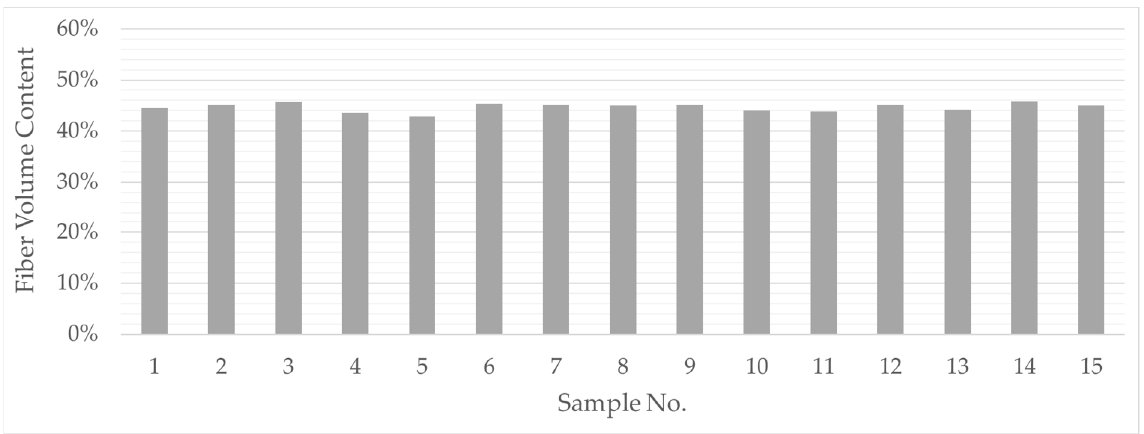
Figure 14. Overview of the measured values for the fiber volume content.